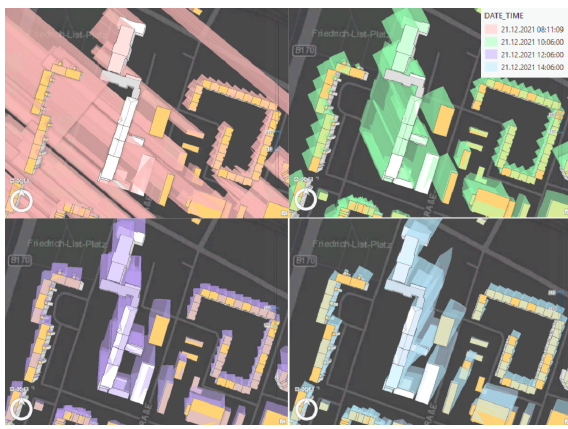
Figure 3. Cross-building shadows in 2-hour interval on winter solstice conducted by Sun Shadow Volume tool